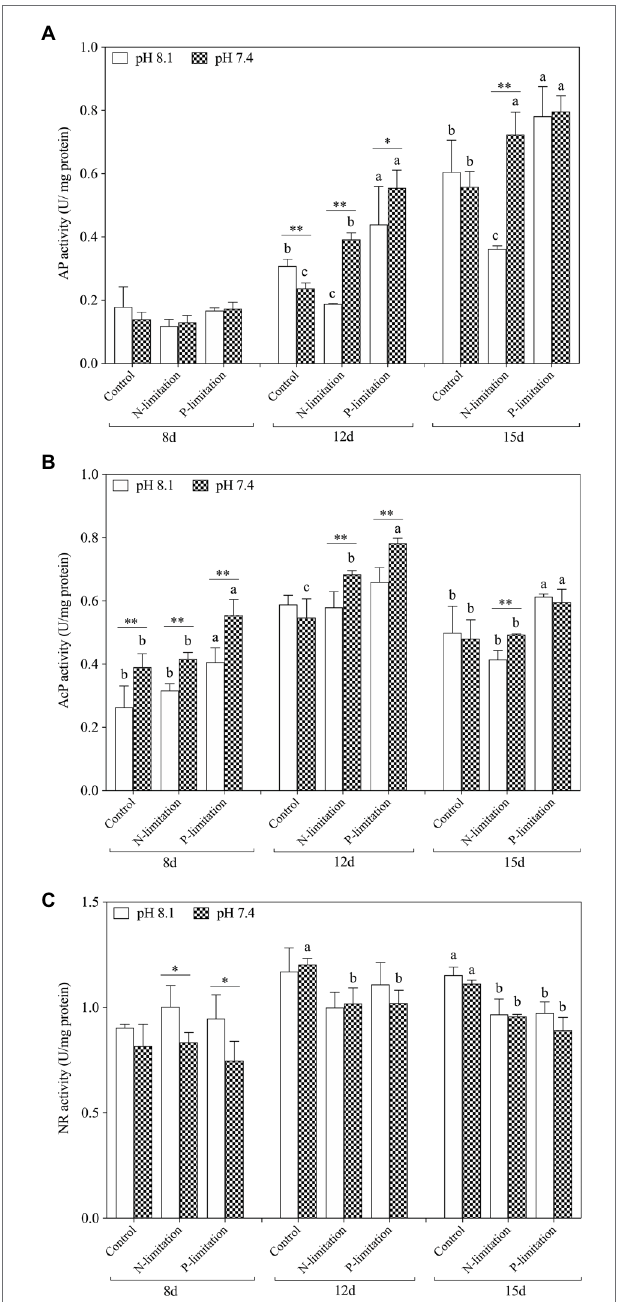
FIGURE 5 | Changes in nutrient absorption-related enzyme activities in K. mikimotoi under seawater acidification conditions when exposed to different nutrient levels. (A) AP activity; (B) AcP activity; (C) NR activity. Data are presented as means ± SD. Different lowercase letters indicate significant differences between three nutrient levels within each pH treatment at each time point ( p < 0.05). Asterisks indicate significant differences between two pH levels within each nutrient treatment ( p <